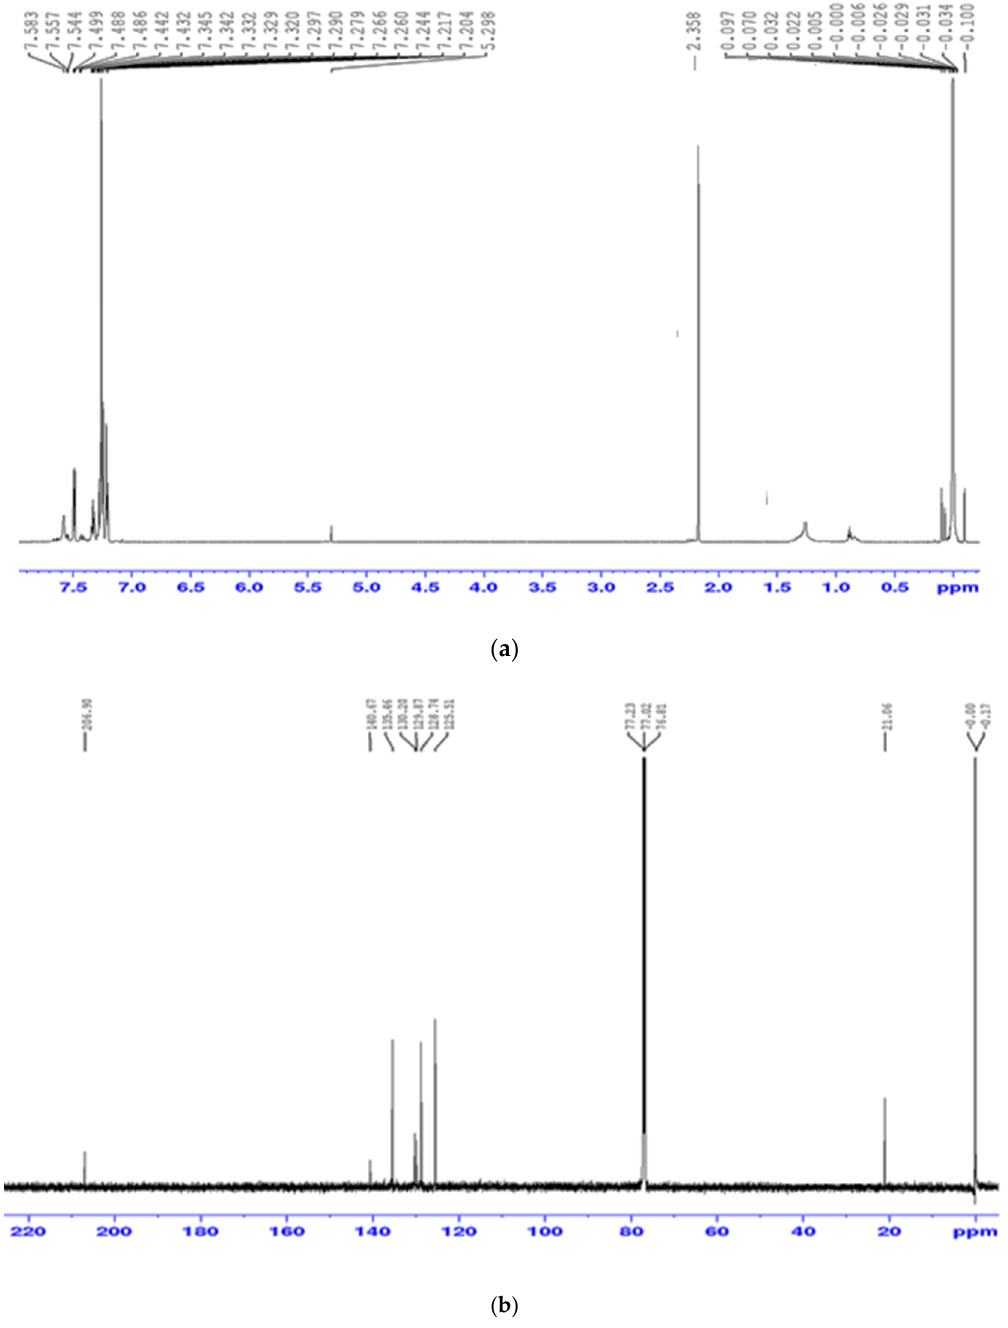
Figure1. 1 H( a )and 13 C( b )spectraofdiphenyltin(IV) p -methylphenyldithiocarbamate [(C 6 H 5 ) 2 Sn(L) 2 ] Figure 1. 1 H ( a ) and 13 C ( b ) spectra of diphenyltin(IV) p -methylphenyldithiocarbamate [(C 6 H 5 ) 2 Sn(L) 2 ] .